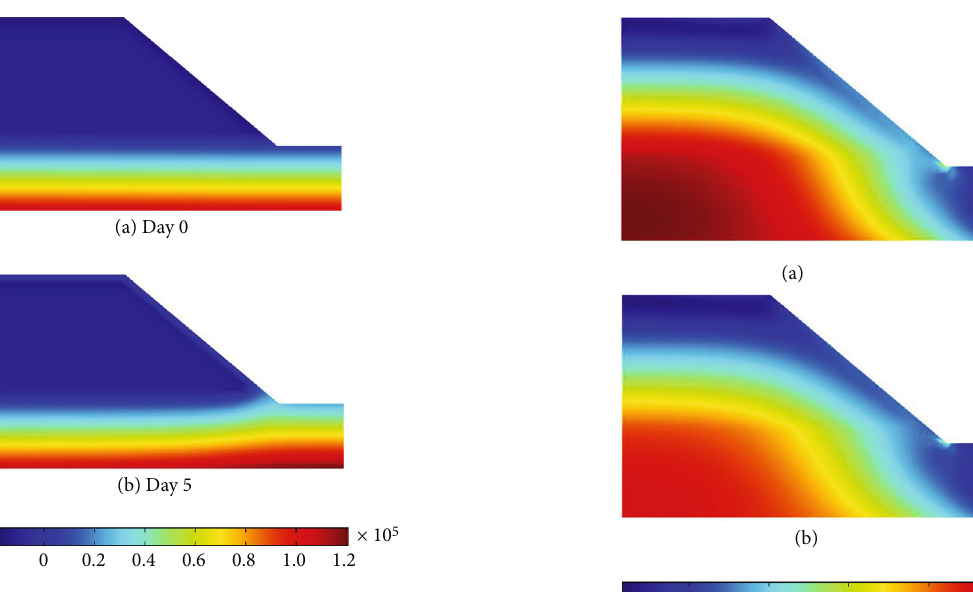
Figure 6: Pore water pressure contours before and after the rainfall in coupling case (unit: Pa).